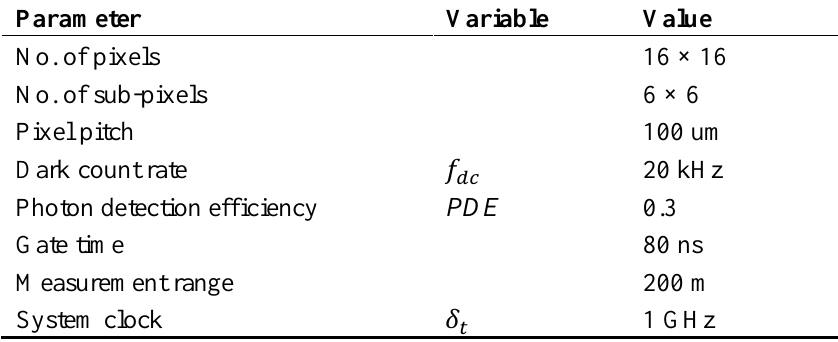
Table 4. Parameters of the detector (related to Equations (1), (15), (16) and (22)).